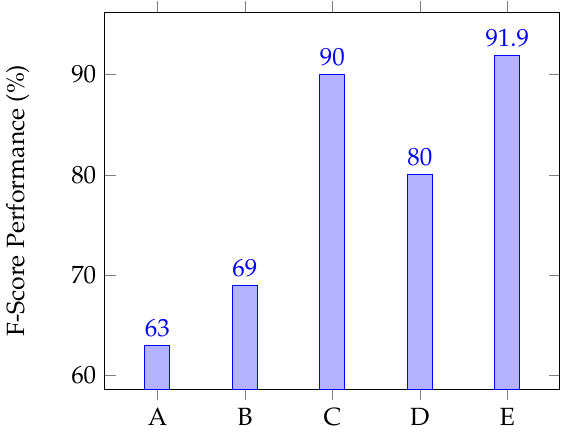
Figure 9. A summary of evaluations using the Kasteren House A dataset for: (A) Kasteren et al. [6]; (B) Ordonez et al. [5]; (C) Ye [39]; (D) Riboni et al. [32]; and (E) this